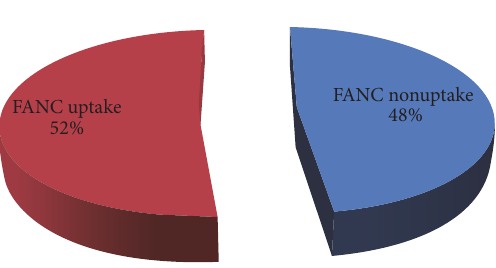
Figure 1: Uptake of focused antenatal